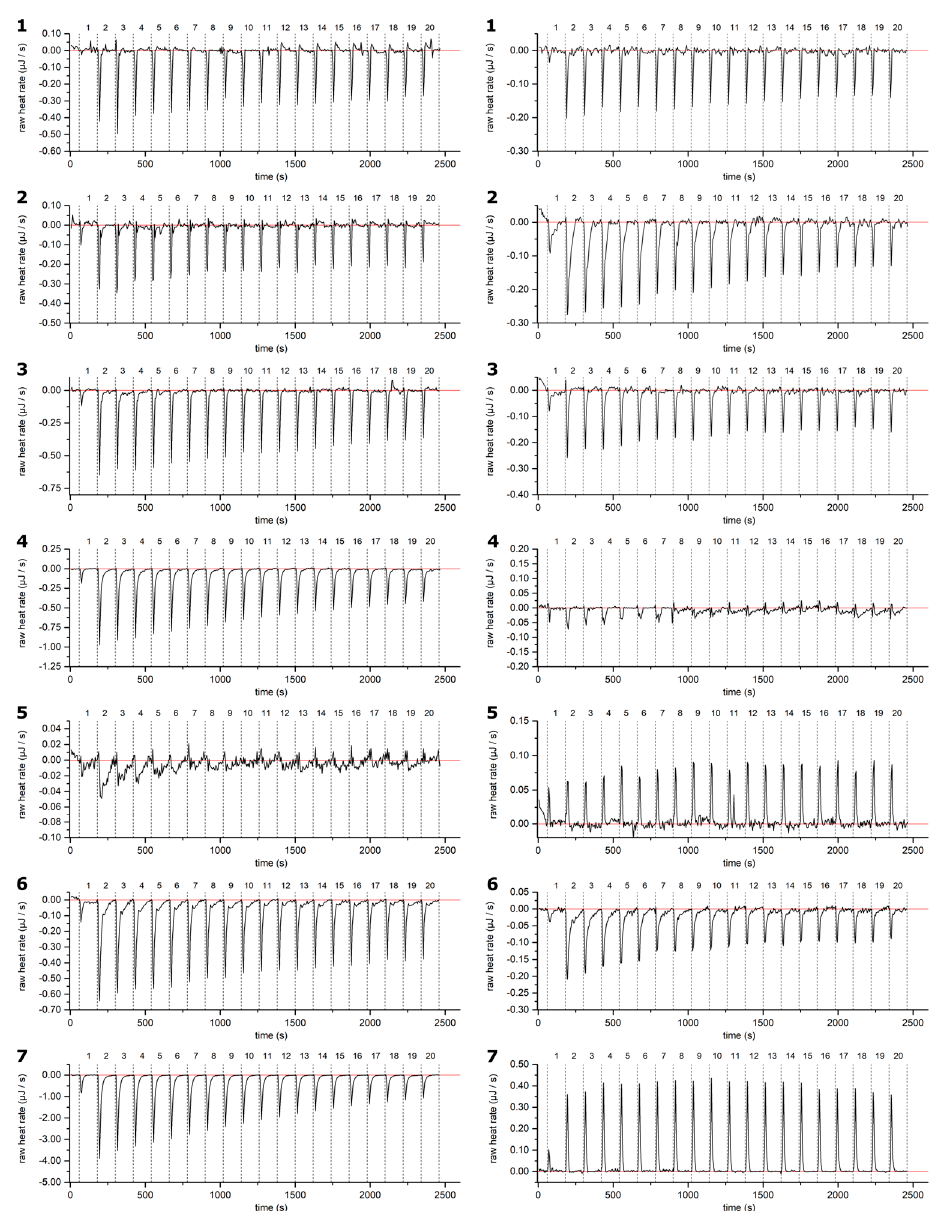
Figure A1. Example thermograms of HTs 1 – 7: samples ( left ) and control ( right , HT titrated into buffer solution): measurements plotted against measurement time. Corrected baseline is presented as a red line, and injections are separated with dashed lines. HTs are presented in order of ascending molecular weight. For the structures and numbering of HTs, refer to Figures 1 and 2.